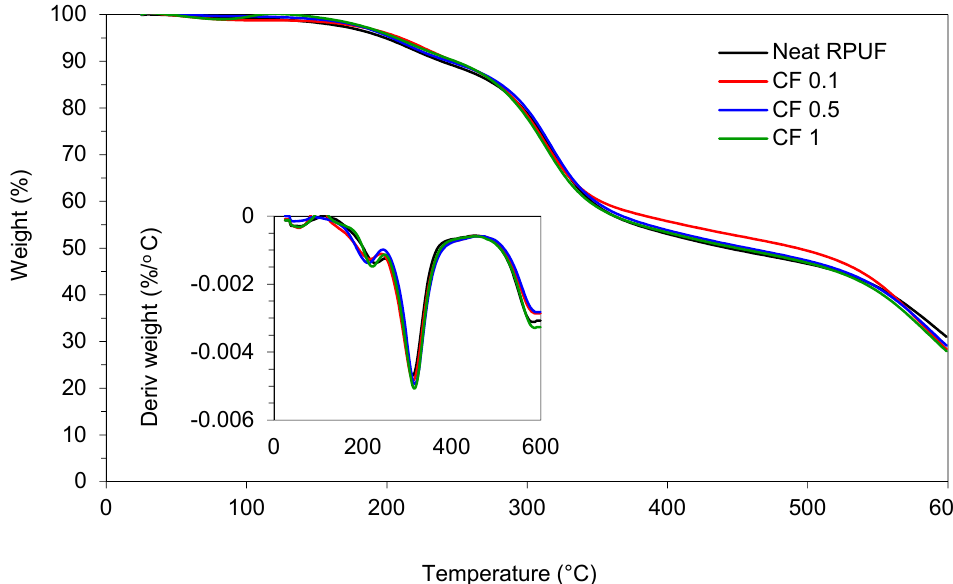
Figure 7. Thermogravimetric curves for the studied RPUF composites. Table 5. Main results from thermogravimetric analysis (TGA) of the studied RPUF composites. Sample